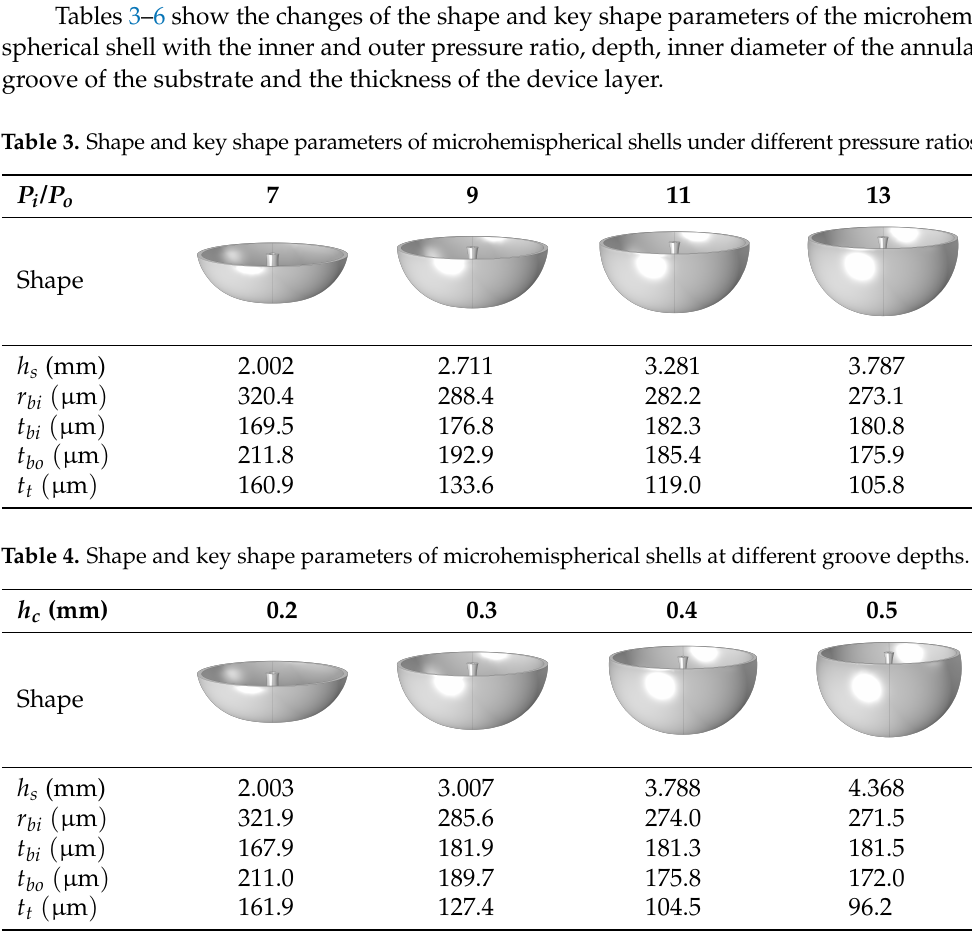
Table 2. Initial values of the depth, inner diameter, outer diameter, pressure ratio of the annular groove and the thickness of device layer. Parameter Value Unit depth of the annular groove ( h c ) 0.3 mm inner diameter of the annular groove ( r i ) 0.5 mm outer diameter of the annular groove ( r o ) 3.5 mm pressure ratio of the annular groove ( P i / P o ) 10 – thickness of device layer ( h ) 0.3 mm